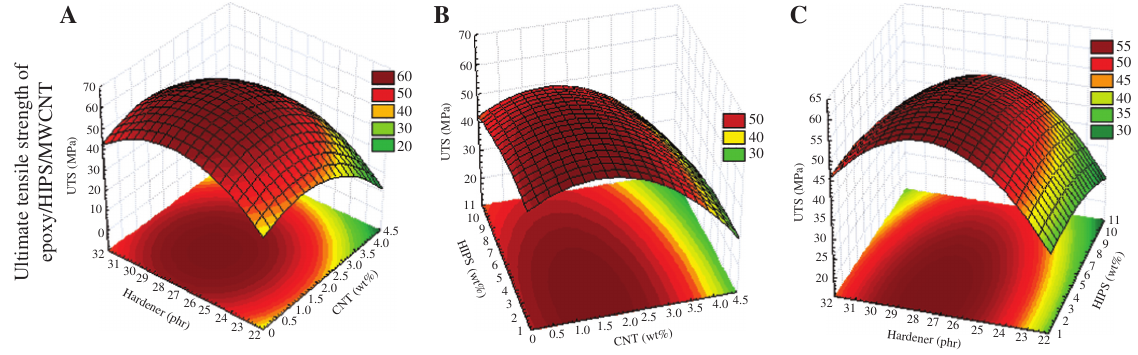
Figure 3 Three-dimensional plots of UTS for (A) HIPS (3.6 wt%), (B) hardener (28 phr) and (C) MWCNT (1.3 wt%).